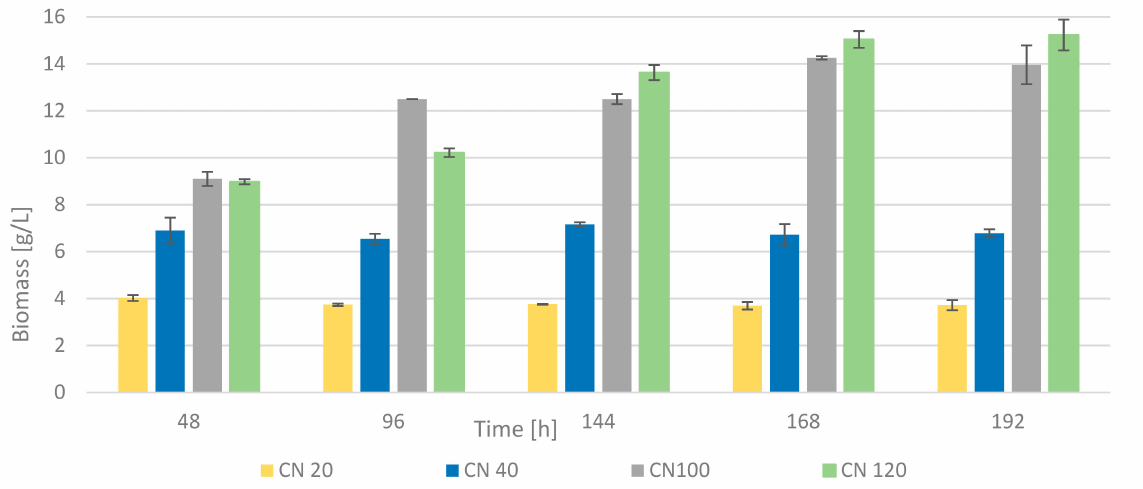
Figure 6. Biomass production with diverse C/N ratio and potassium nitrate as a N